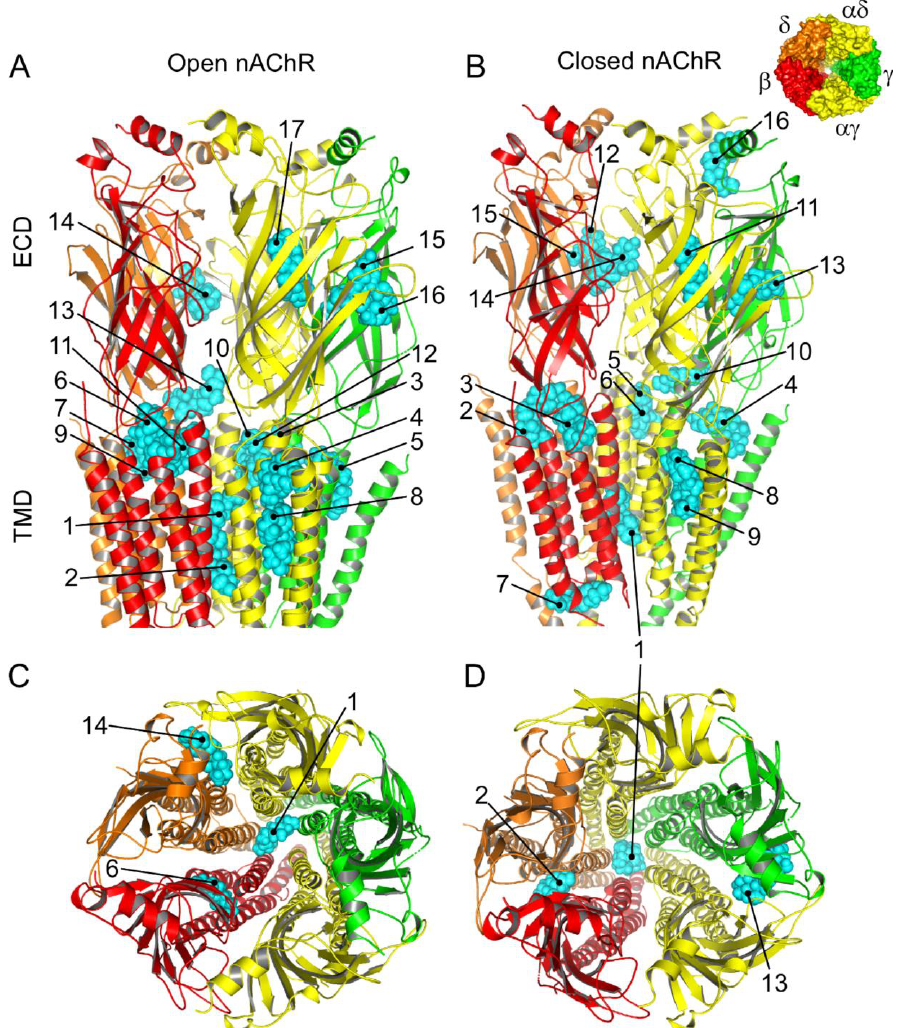
Fig.9 Figure 9. Predicted binding sites for Pm-nAChR complexes. ( A , B ) Lateral view of the nAChR displaying the main Pm (labelled in cyan) clusters bound to the open ( A ) and closed ( B ) conformations. The predicted loci are numbered consecutively, beginning in the transmembrane (TMD) and later in the extracellular (ECD) domain. (C, D) Top view of the nAChR (from the synaptic cleft) displaying representative Pm clusters binding to residues located within the channel pore, TMD, and ECD in the open ( C ) and closed ( D ) conformations. The inset, in the upper right corner, displays the nAChR subunits with their color